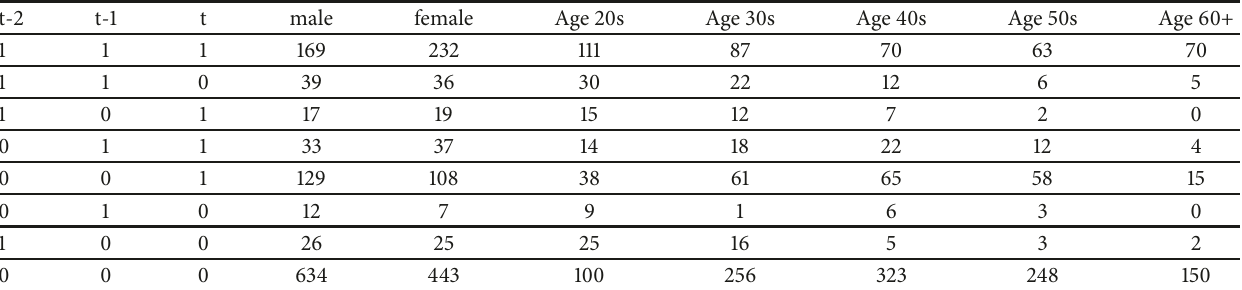
Table 4: Transit use status over time from (t-2) to (t).